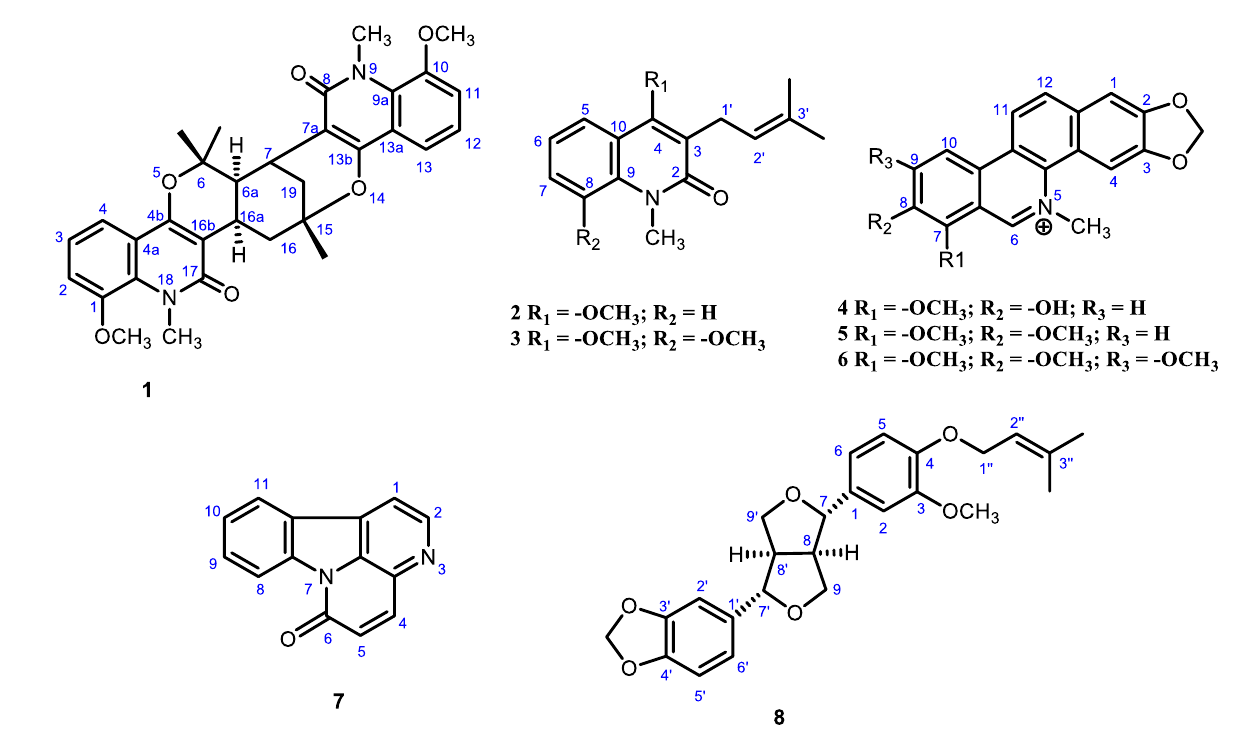
Figure 1. Structures of the compounds isolated from Zanthoxylum rhetsa .